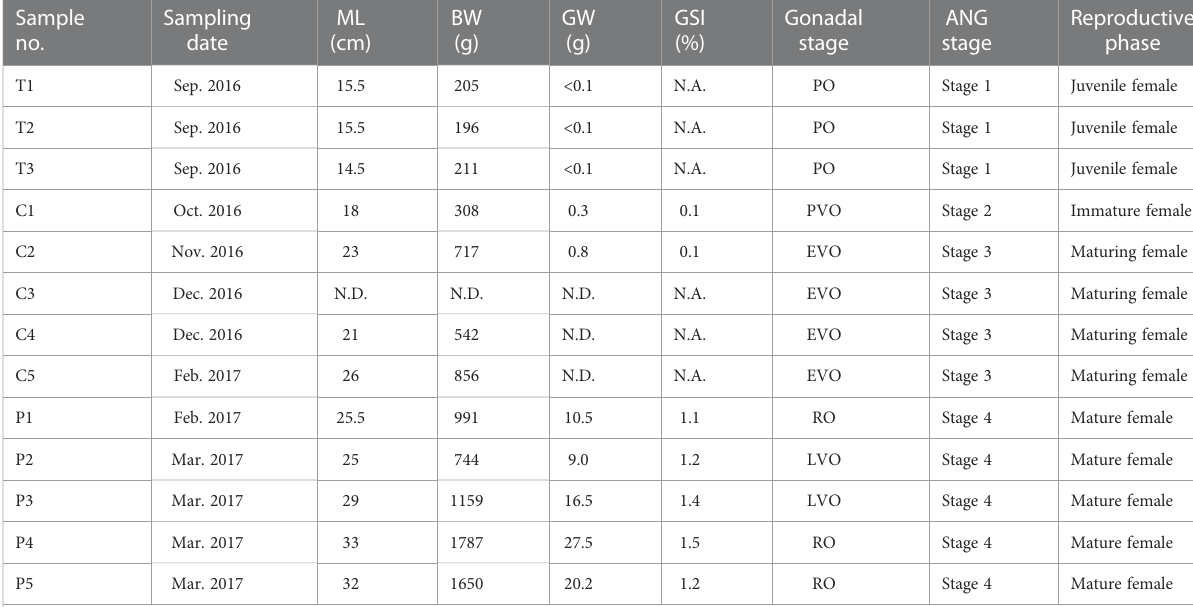
TABLE 1 Characteristics of sampled squids. Sample